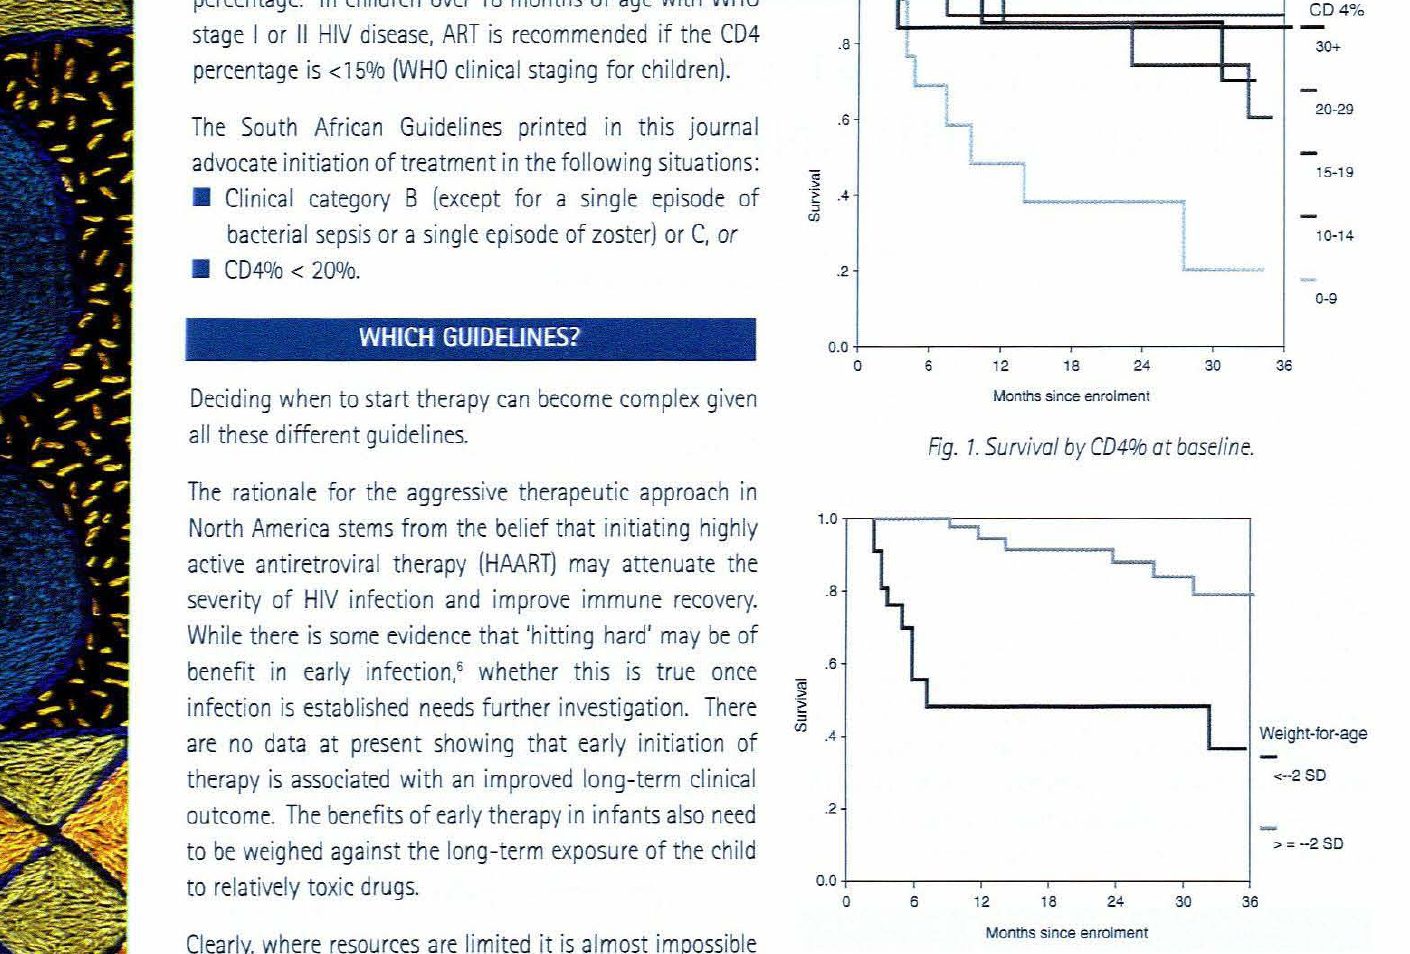
Fig. 7. Survival by CD4% at baseline.